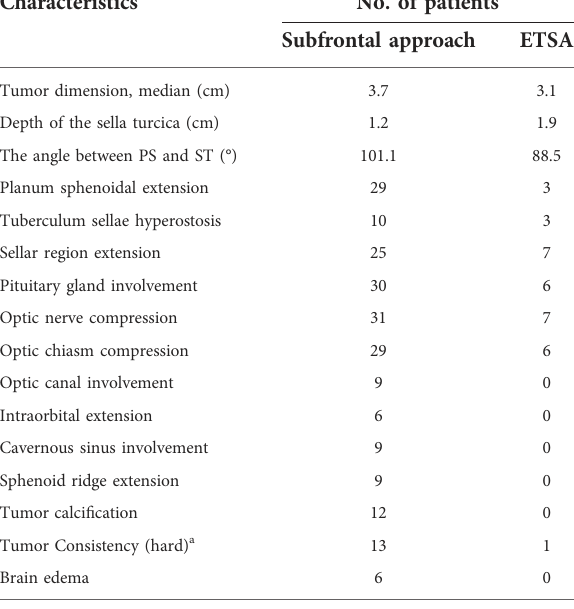
TABLE 1 Clinical characteristics of patients with giant TSMs.